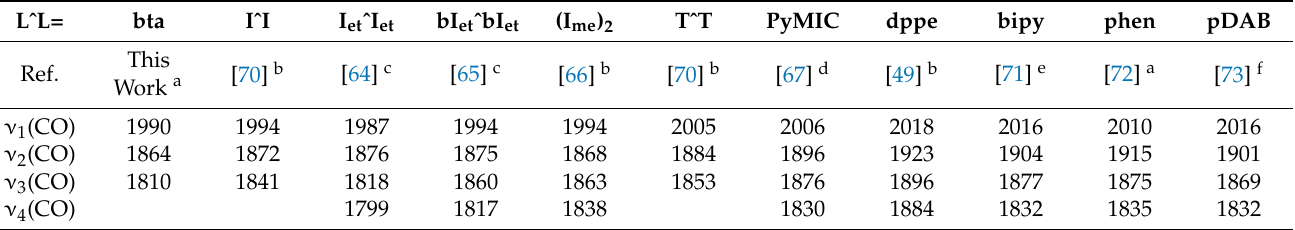
Table 3. Selected examples of CO stretching vibrations (in cm − 1 ) in the IR spectra of Mo(CO) 4 (LˆL) complexes (LˆL = chelating